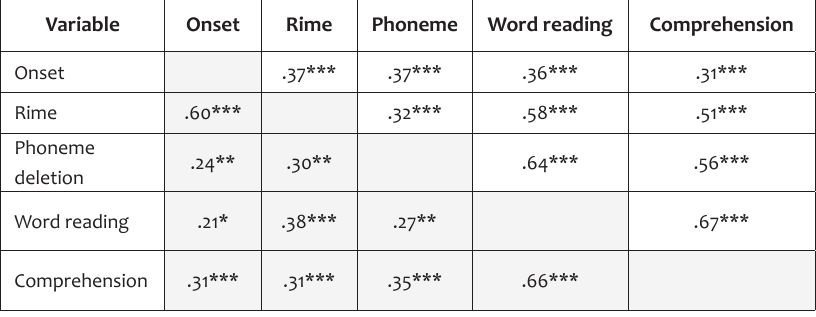
the correlation. By applying Fisher’s z transformations ( cf. Hays, 1994), all pair-wise comparisons between the correlations can be tested. Significant correlations were found for onset-rime ( r = .60 vs. r = .37; Zr = 2.595, p < .001) and phoneme-reading